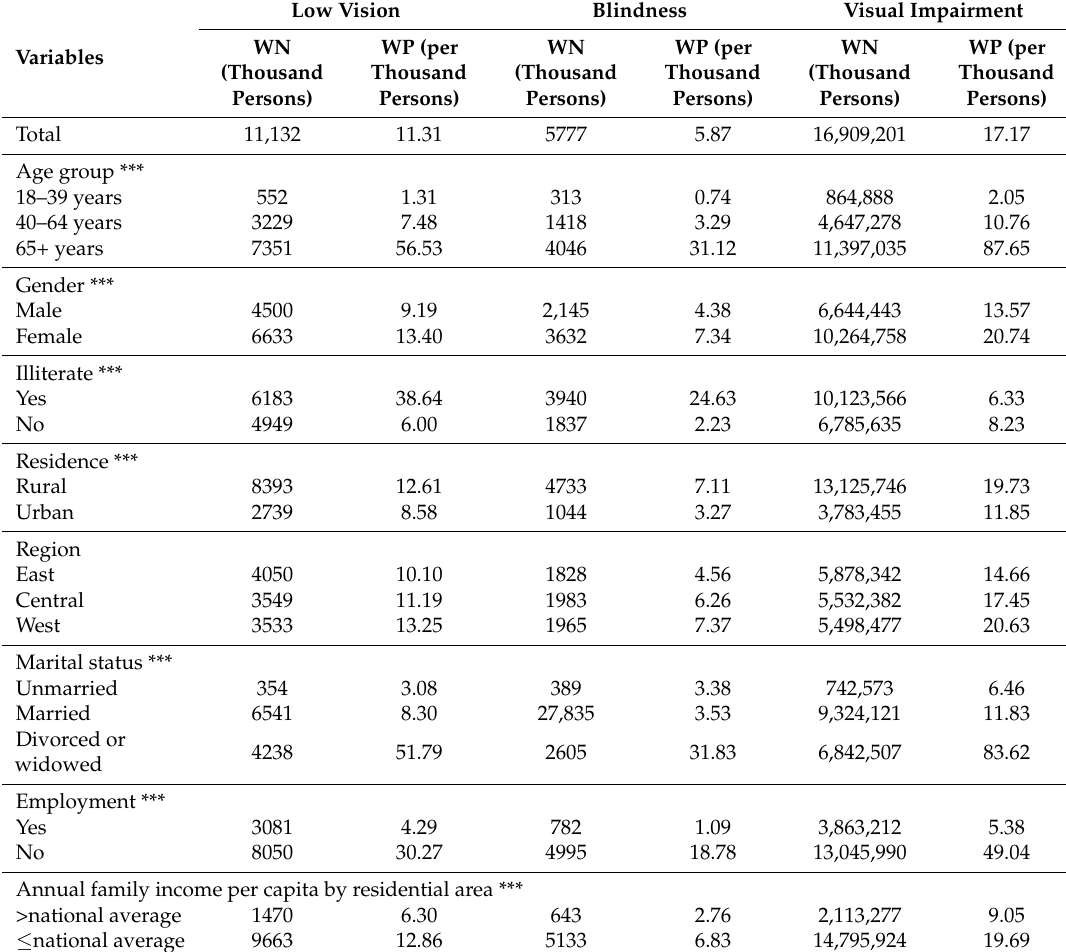
Table 2. The prevalence of low vision, blindness, and visual impairment among Chinese adults.